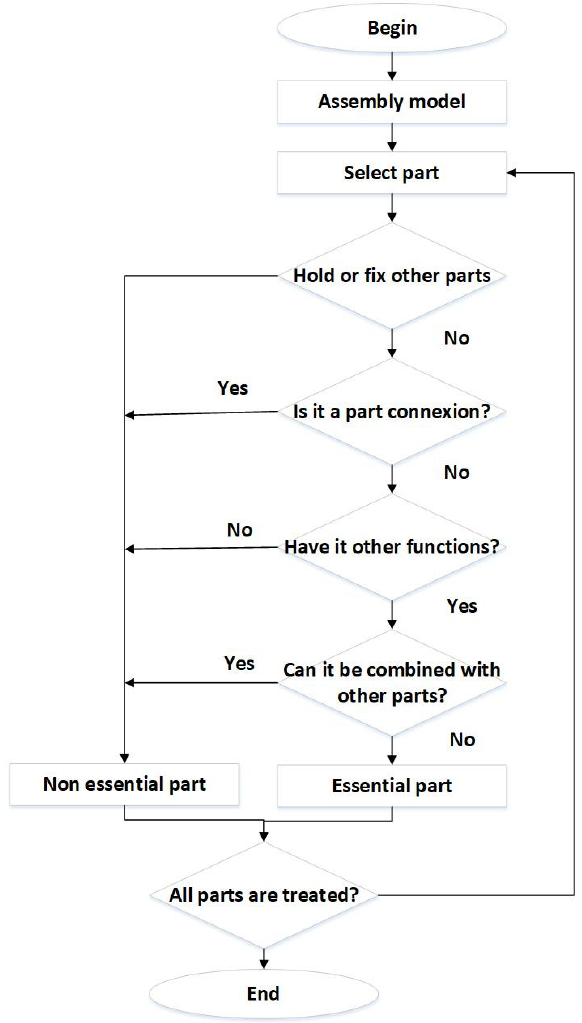
Figure 3. Algorithm for classifying components into essential and non-essential .